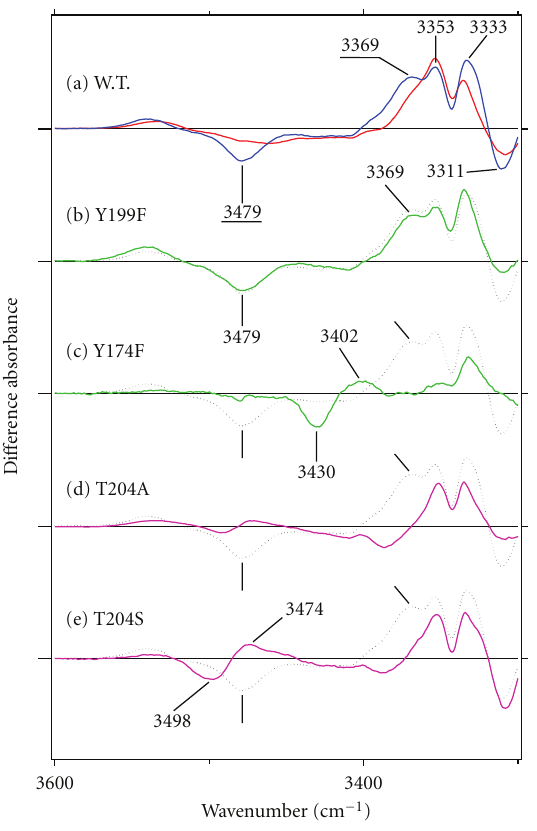
Figure 4: (a) p pR minus p pR infrared di ff erence spectra in the K absence (red line) and presence (blue line) of the transducer pro- tein, p HtrII, in the 3600–3300 cm − 1 region. Spectra are measured at minus p pR 77K and pH 7 upon hydration with D 2 O. (b–e) p pR K infrared di ff erence spectra of the wild type (black dotted lines) and mutant (solid lines; (b) Y199F, (c) Y174F, (d) T204A, (e) T204S) proteins of p pR in the presence of p HtrII in the 3600–3300 cm − 1 region. Spectra are measured at 77 K and pH 7 upon hydration with D 2 O . The original data appeared in